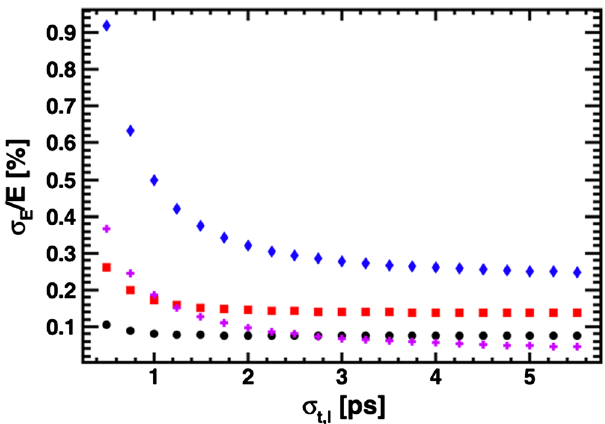
FIG. 7. The minimal achievable bandwidth (for a vanishing aperture) as function of the laser beam pulse duration, for a transverse size of σ x;y ; l ¼ 7 . 5 μ m in both horizontal and vertical directions and laser beam single pulse energies of 25 mJ (black dots), 100 mJ (red squares), and 400 mJ (blue diamonds). The similar curve with formula of Ref. [11] for a 25 mJ laser beam is given with pink